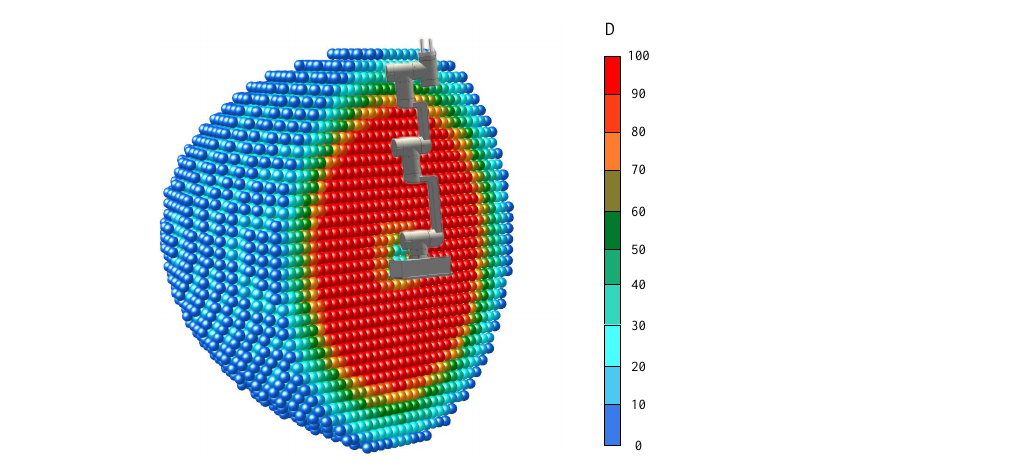
Figure 7. The distribution of the reachability index of all sub-workspaces in the workspace.